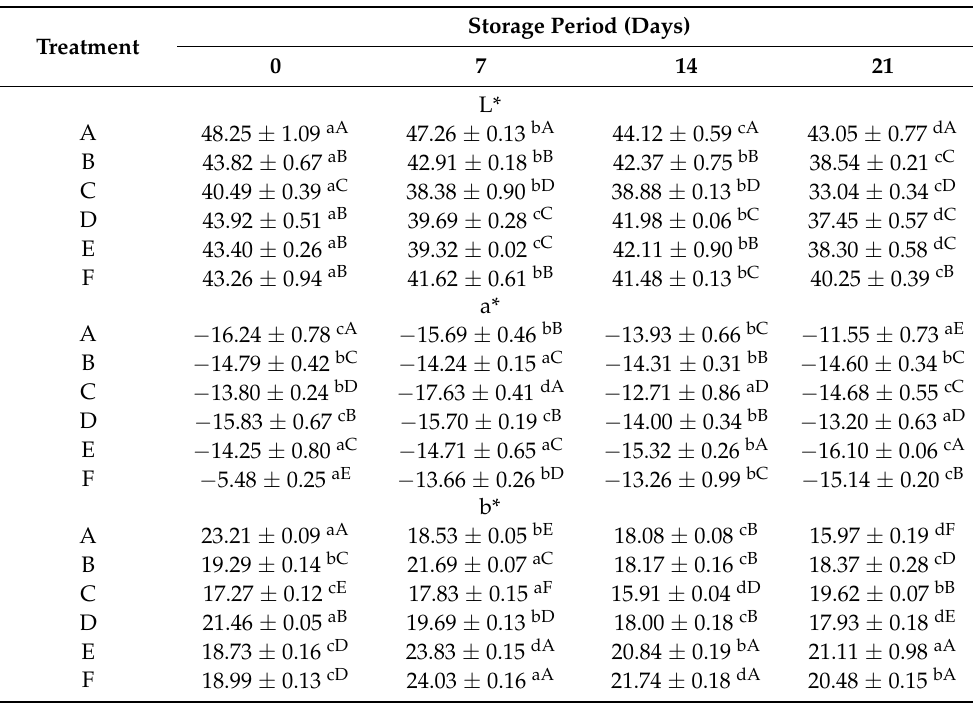
Values are means of triplicate samples ( ± SD). Means not sharing common lower-case letters in a row (storage) or capital letters in a column (treatments) are significantly different at p ≤ 0.05 as assessed by Duncan’s Multiple Range Test. A: Uncoated, B: Coated with 2% chitosan only, C: Coated with 2% chitosan containing 1% OCE, D: Coated with 2% chitosan containing 2% OCE, E: Coated with 2% chitosan containing 1% OPE, and F: Coated with 2% chitosan containing 2%